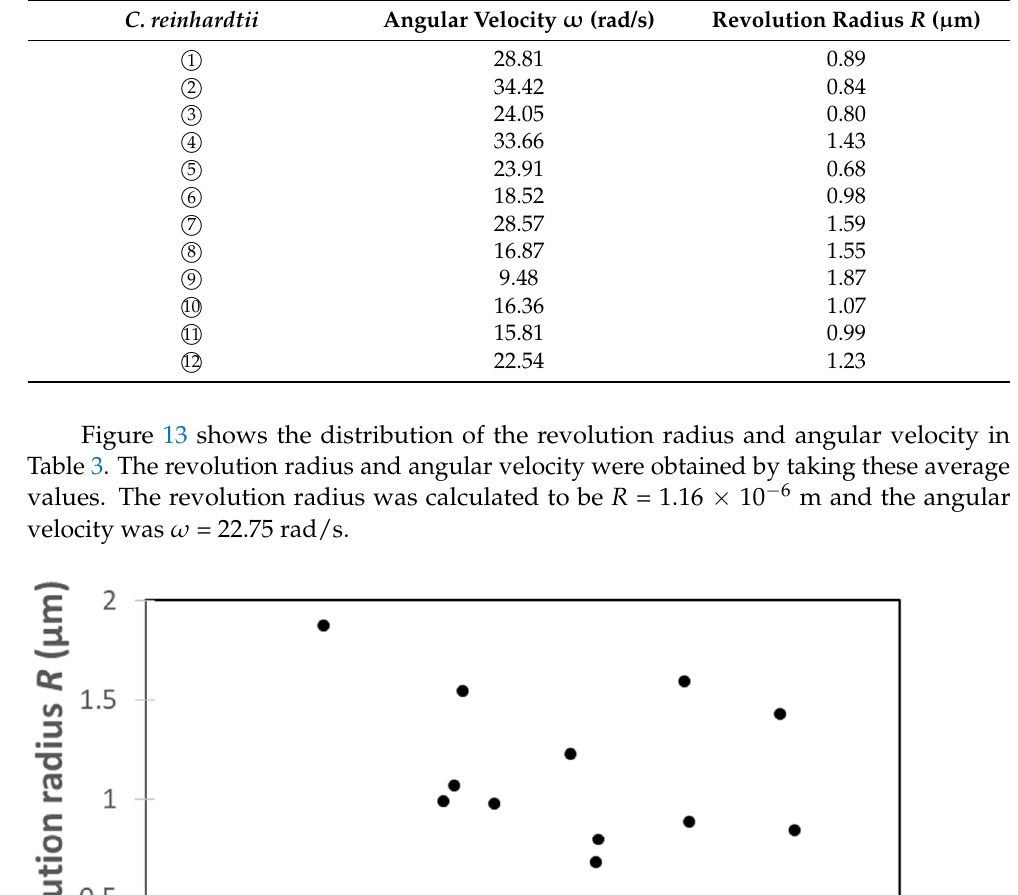
Table 3. Angular velocity and revolution radius of C. reinhardtii obtained from video image analysis. C. reinhardtii